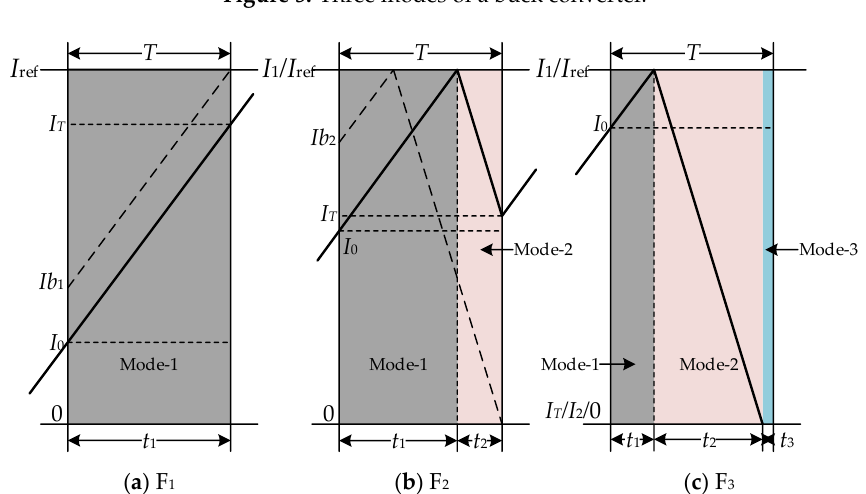
Figure 5. Three modes of a buck converter.